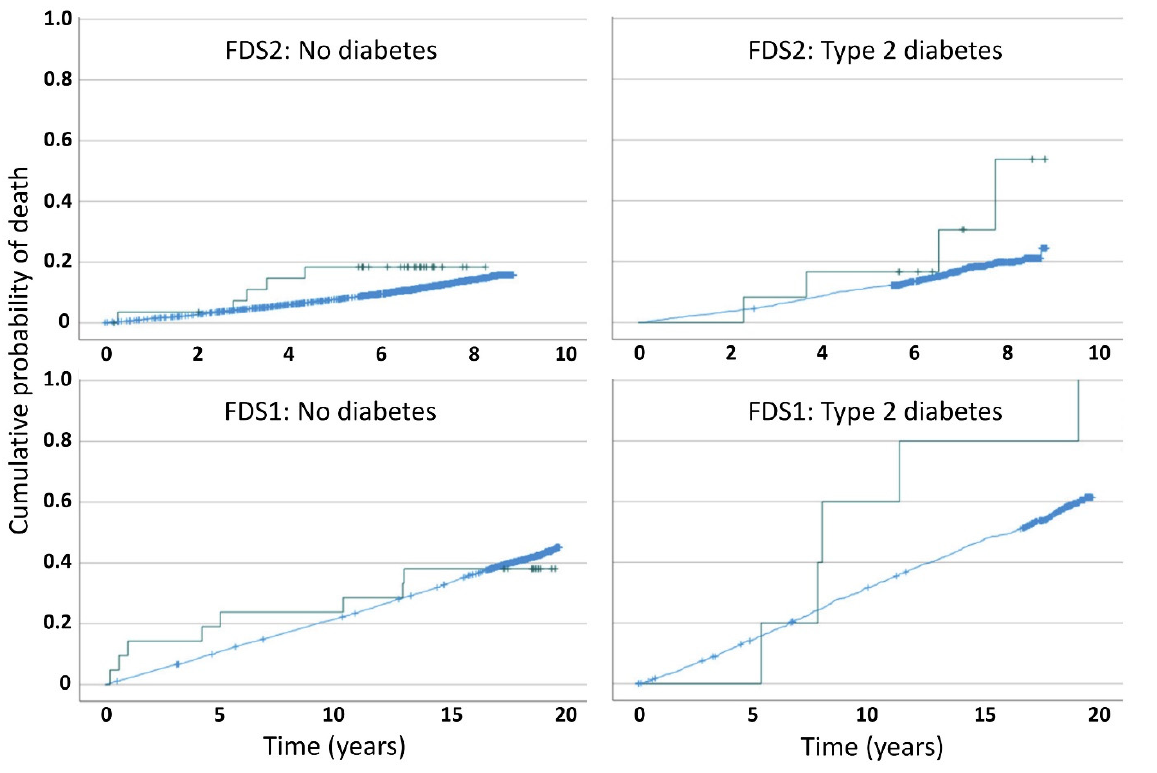
Figure 1. Cumulative mortality estimates by type 2 diabetes and schizophrenia status for each Fremantle Diabetes Study Phase. In each panel, no schizophrenia is the blue line and schizophrenia the green line. Censored points are shown as +.